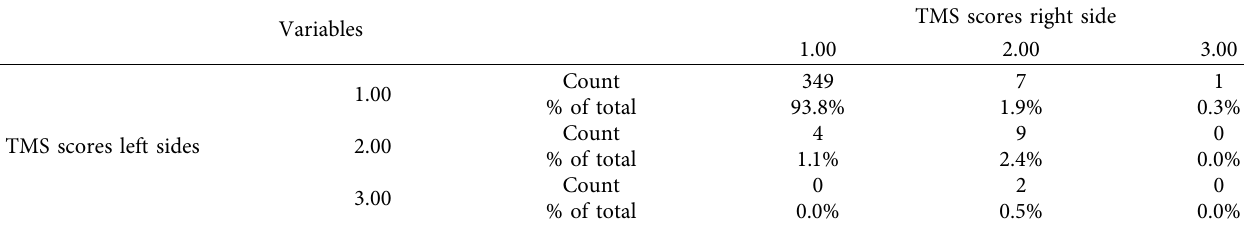
Table 5: TMS scores in the right and left sides.